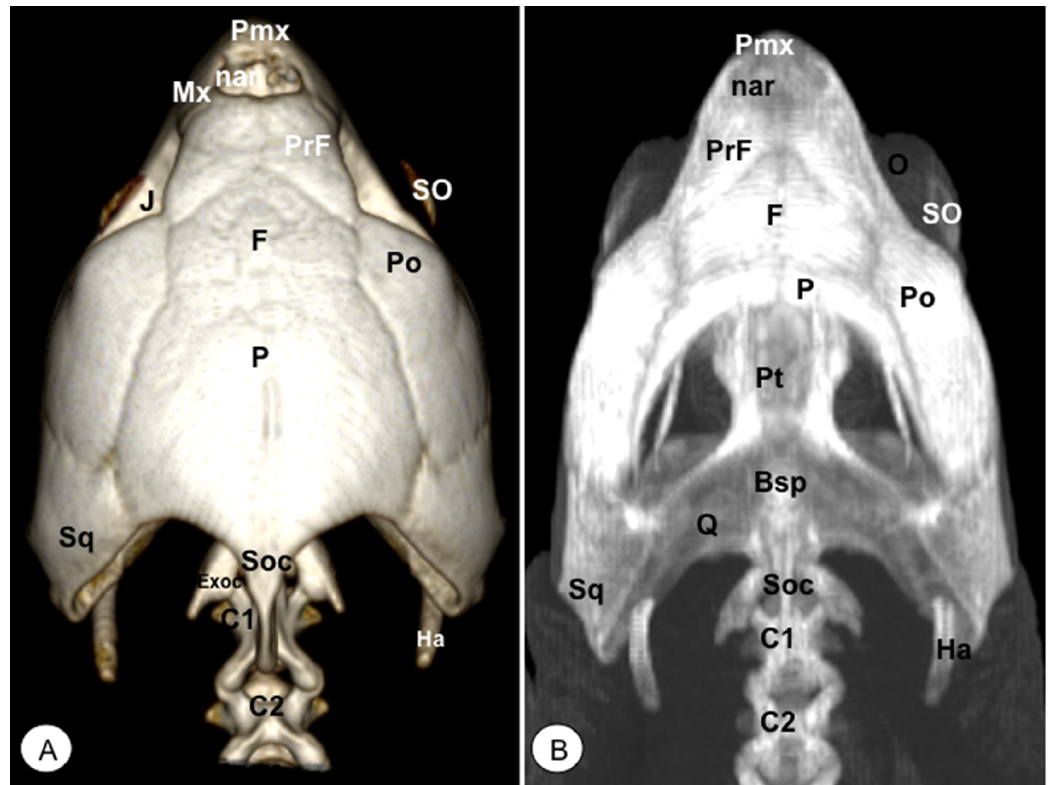
Figure 5. Head of Caretta caretta . ( A ) Dorsal VR image. ( B ) Dorsal MIP. Pmx: Premaxillary bone. Mx: Maxillary bone. nar: Nares. PrF: Prefrontal. F: Frontal. Po: Postorbital. J: Jugal. O: Orbit. SO: Scleral ossifications. Sq: Squamosal. Pt: Pterygoid. Bsp: Basisphenoid. P: Parietal. Exoc: Exoccipital. Soc: Supraoccipital. Ha: Hyoid apparatus. C1: First cervical vertebra. C2: Second cervical vertebra.